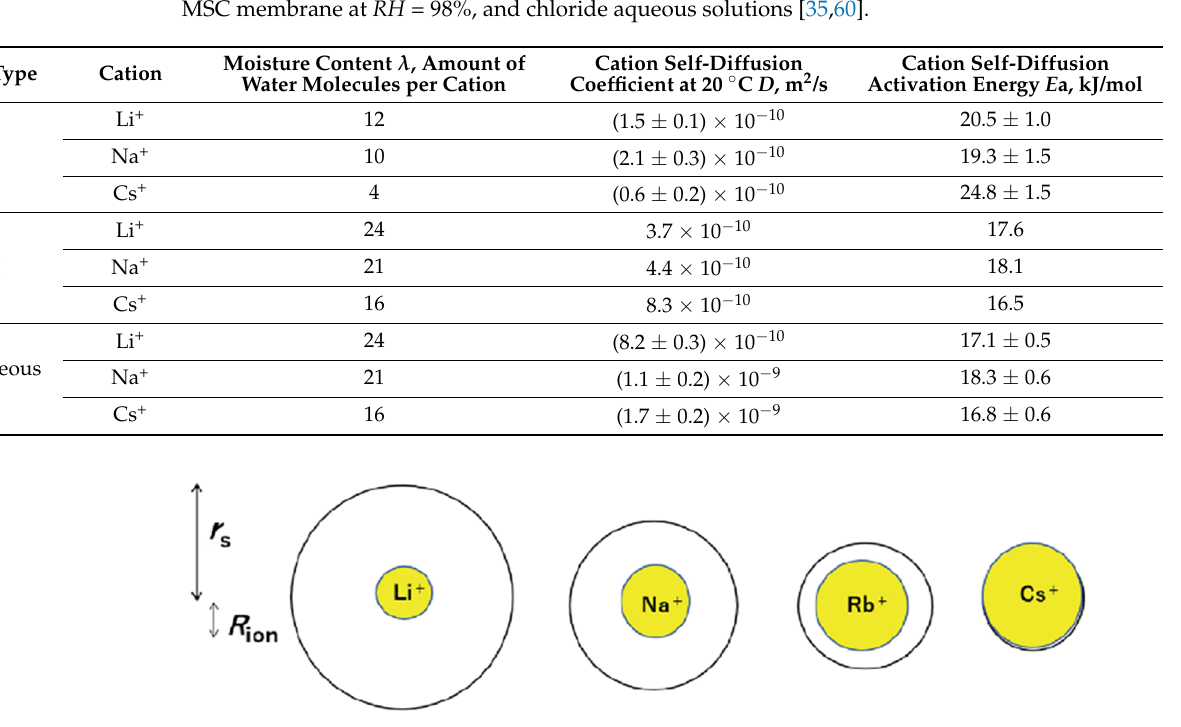
Figure 26. Relations between the dynamic ionic radius ( r s ) and static ionic radius ( R ion ) for the alkaline metal ions in aqueous solutions. Reprinted with permission from Ref. [112]. Copyright 2021 the Royal Society of Chemistry.